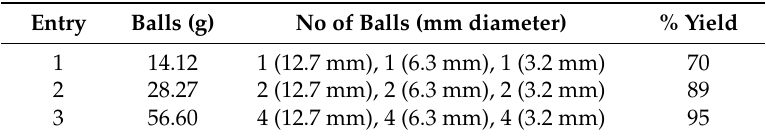
Table 2. Milling of 2.5 g of o -phenylenediamine and 3 g of benzoic acid at 20 Hz for 60 min.